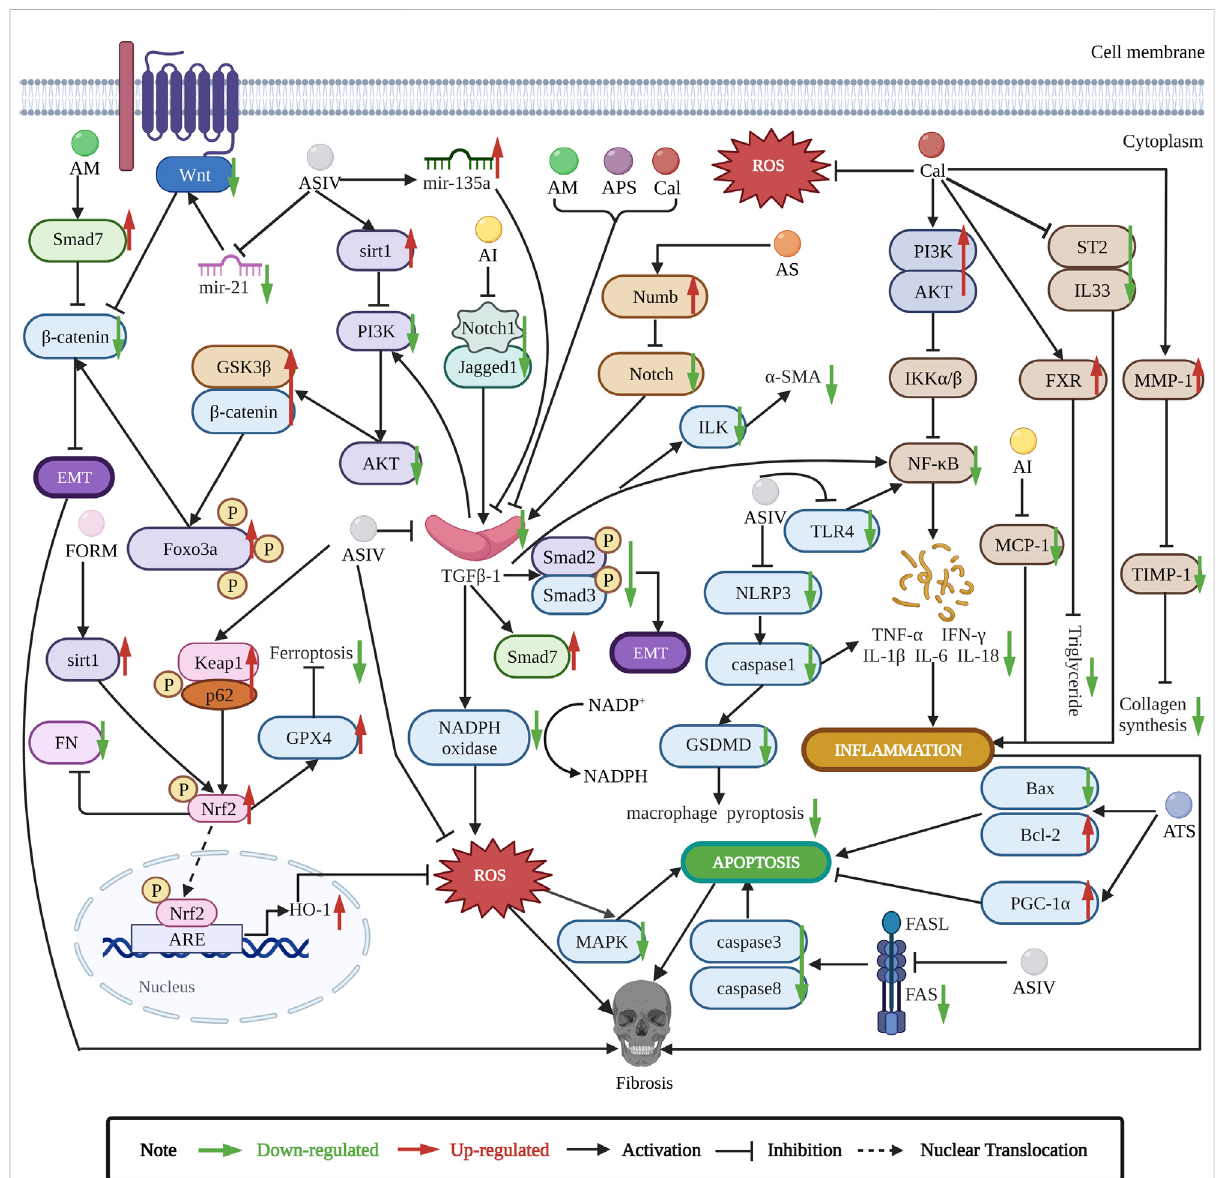
FIGURE 2 Astragalus exertsanti fi brosiseffects byinhibiting EMT,ROS,TGF- β 1/Smads,apoptosis,andin fl ammationpathways.ASIVisthemainanti fi brotic component of Astragalus . ASIV downregulates mir-21/Wnt/ β -catenin/EMT pathway (Wang et al., 2018), TGF- β 1/PI3K/AKT/Foxo3a/EMT pathway (Qian et al., 2018), and sirt1 AS/EMT pathway (Qian et al., 2020). ASIV also regulates mir-135a/TGF- β /Smads pathway (Wei et al., 2020). ASIV reduces oxidative stress by upregulating p62/Keap1/Nrf2 pathway (Gao et al., 2020), ASIV enhances Nrf2 signaling to inhibit ROS-induced ferroptosis (Luoetal.,2021).Inaddition,ASIVcanmodulateMAPKandNF- κ Bsignalingpathwaystoinhibitin fl ammationandapoptosis(Xuetal.,2014;Cheetal., 2015; Dai et al., 2017; Zhou et al., 2017). ASIV inhibits NLRP3/caspase1 pathway (Wan et al., 2018; Zhang et al., 2022b). ASIV downregulates FAS/FASL pathway to inhibit apoptosis (Liu et al., 2019b). ASIV also reduces TNF- α and IL-6 expression to inhibit in fl ammation (Qian et al., 2018). Cal can suppress TGFBR1 signaling pathway (Chen et al., 2022). Cal also modulates PI3K/AKT and IL33/ST2 pathways to suppress in fl ammation (Elsherbiny et al., 2020; Wang et al., 2022b). Cal activates FXR to reduce triglyceride (Duan et al., 2017). Cal reduces ROS and balances MMP-1/TIMP-1 system to inhibit collagen synthesis (Zhang et al., 2021a). AI inhibits Jagged1/Notch1//TGF- β 1/Smads/EMT and TGF- β 1/NADPH oxidase/ROS pathways (Liu et al., 2014; Zhou et al., 2016b), AI can reduce MCP-1 expression to inhibit in fl ammation (Li et al., 2014b). FORM can regulate sirt1/Nrf2/ARE/ROS signaling pathway (Zhuang et al., 2020). AM modulates Smad7/ β -catenin/EMT pathway (Yu et al., 2018). AS regulates numb/Notch/TGF- β 1 pathway (Yongping et al., 2015). APS inhibits TGF- β 1/ILK pathway to reduce in fl ammation (Zheng et al., 2021). ATS modulates PGC-1 α and Bax/Bcl2/ caspase3 pathway to inhibit apoptosis (Li et al.,